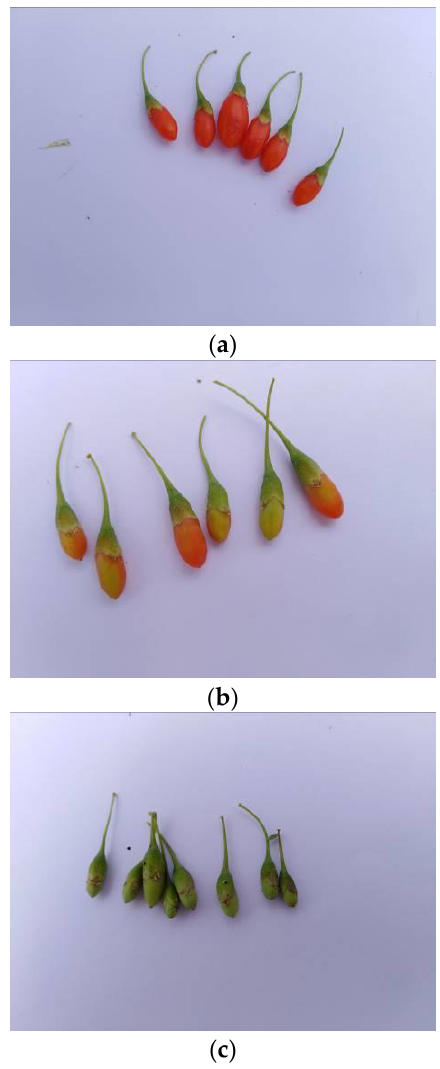
Figure 1. Fresh L. barbarum fruit at different maturity levels. ( a ) Ripe fruit, ( b ) half-ripe fruit, and ( c ) unripe fruit.